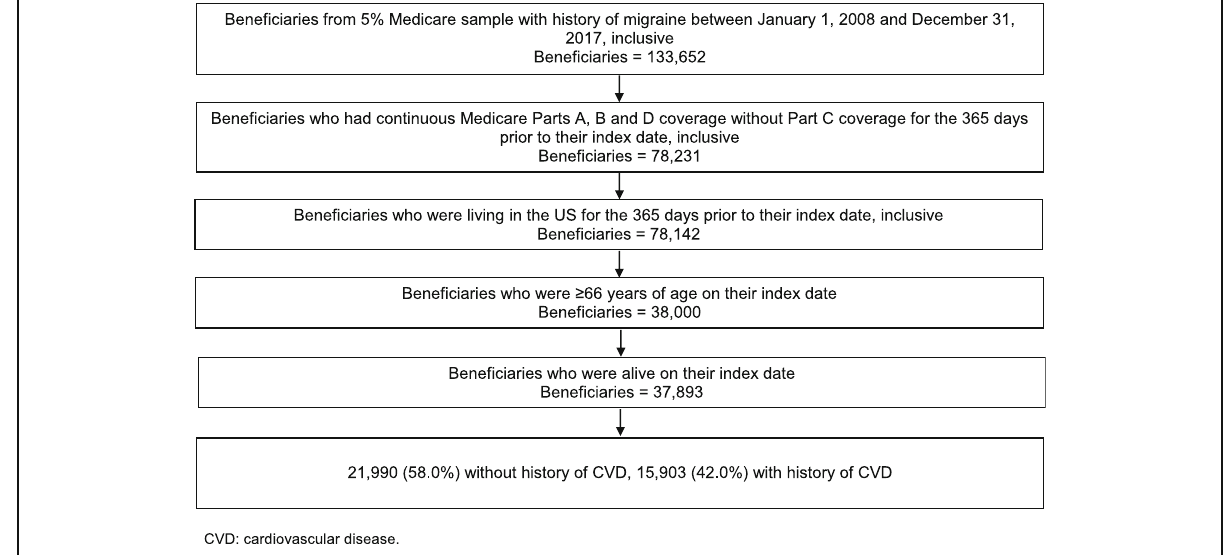
Fig. 1 Consort diagram of Medicare beneficiaries with a history of migraine included and not included in the current analysis. CVD: cardiovascular